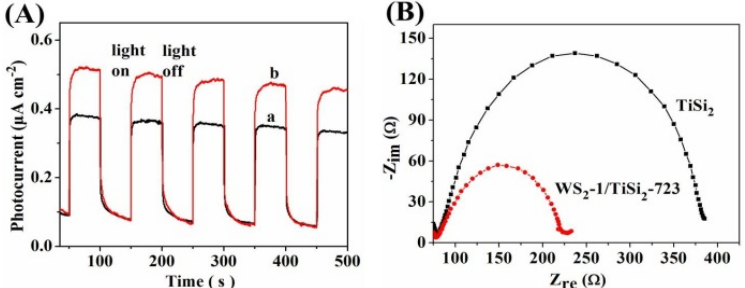
Figure 6. ( A ) Photocurrent of the electrodes made of (a) TiSi 2 and (b) WS 2 ‐ 1/TiSi 2 ‐ 723 catalysts under UV ‐ vis light irradiation at 0.5 V vs. SCE. The electrolyte was 0.5 M Na 2 SO 4 aqueous solution. The illumination from a 150 W xenon lamp was interrupted every 50 s; ( B ) Nyquist plots of